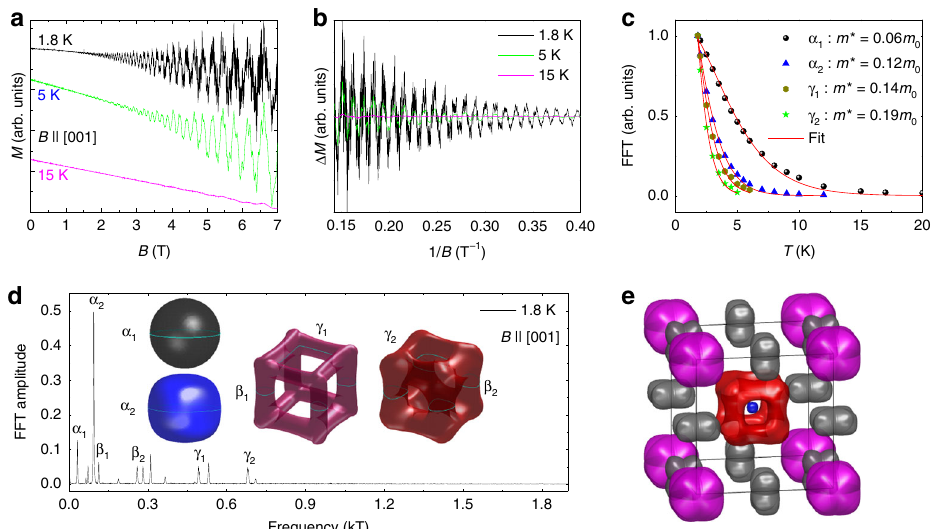
Fig. 2 Detection of spin-split Fermi-surface pockets with quantum oscillations. a Isothermal magnetization with dHvA quantum oscillations observed at different temperatures for B ||[001]. b Corresponding dHvA signal after subtracting a smooth background. c Temperature dependence of FFT amplitudes for selected peaks illustrated in d . The Fermi-surface pockets with the identi fi ed extremal areas are shown in the inset of d . e Overall 3D Fermi-surface pockets combined in the fi rst